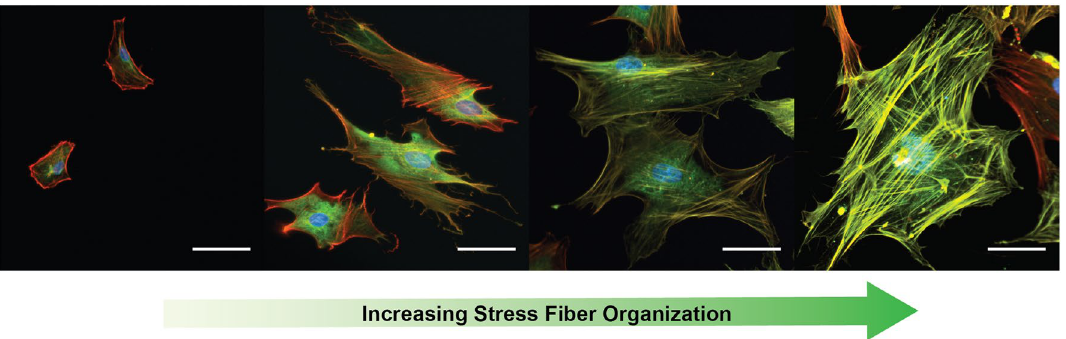
Figure 1. Fixed and stained cardiac fibroblasts with increasing levels of α-SMA stress fiber organization. Myofibroblast activation has been shown to correlate with α-SMA SF + phenotypes. Red: F-actin, Green: alpha- smooth muscle actin, Blue: Nuclei, scale bar = 50